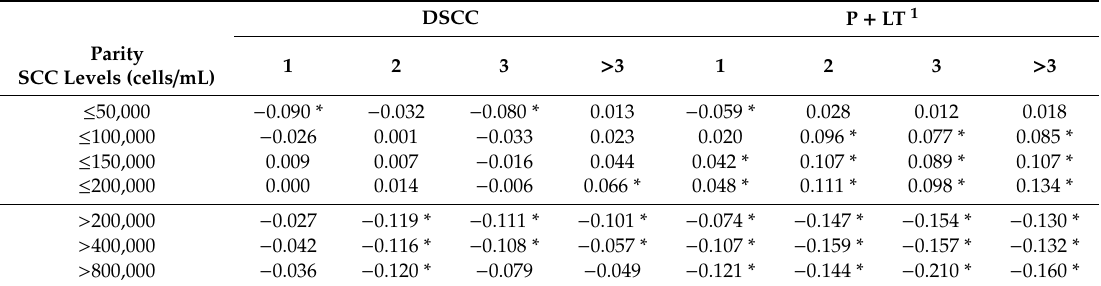
Figure 4. PL + T patterns during lactation classified by parity and Somatic Cell Count level ( > 200,000 cells / mL; > 400,000 cells / m; > 800,000 cells / m). P + LT is equal to SCC × milk yield × DSCC (as proportion). Table 7. Results of the Mann-Kendall test to identify trends during lactation for Di ff erential Somatic Cell Count (DSCC) and P + LT ranked by Somatic Cell Count (SCC) levels and parity in healthy and diseases